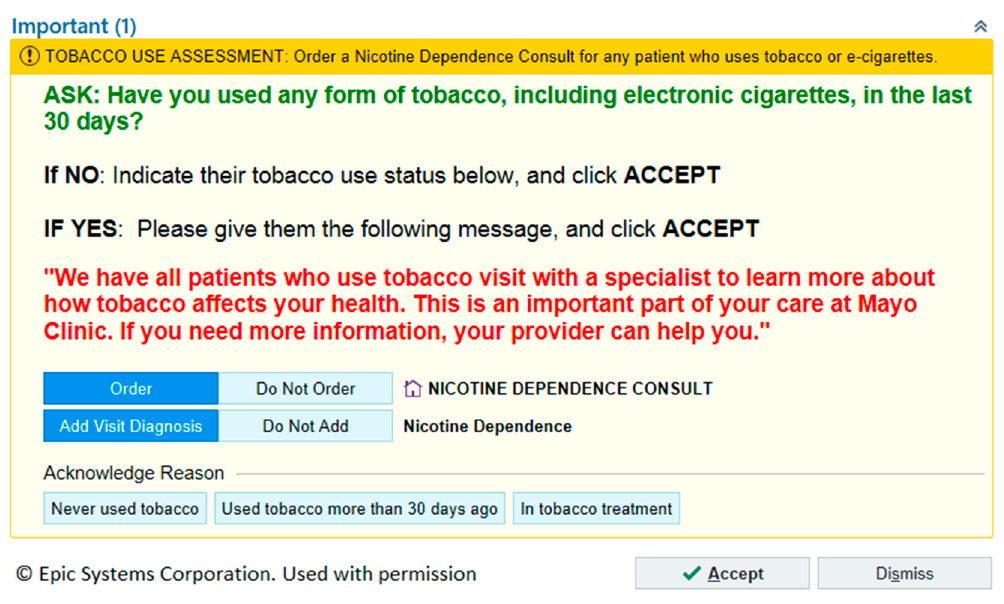
Figure 1. Epic © best practice advisory alert for tobacco use intervention.